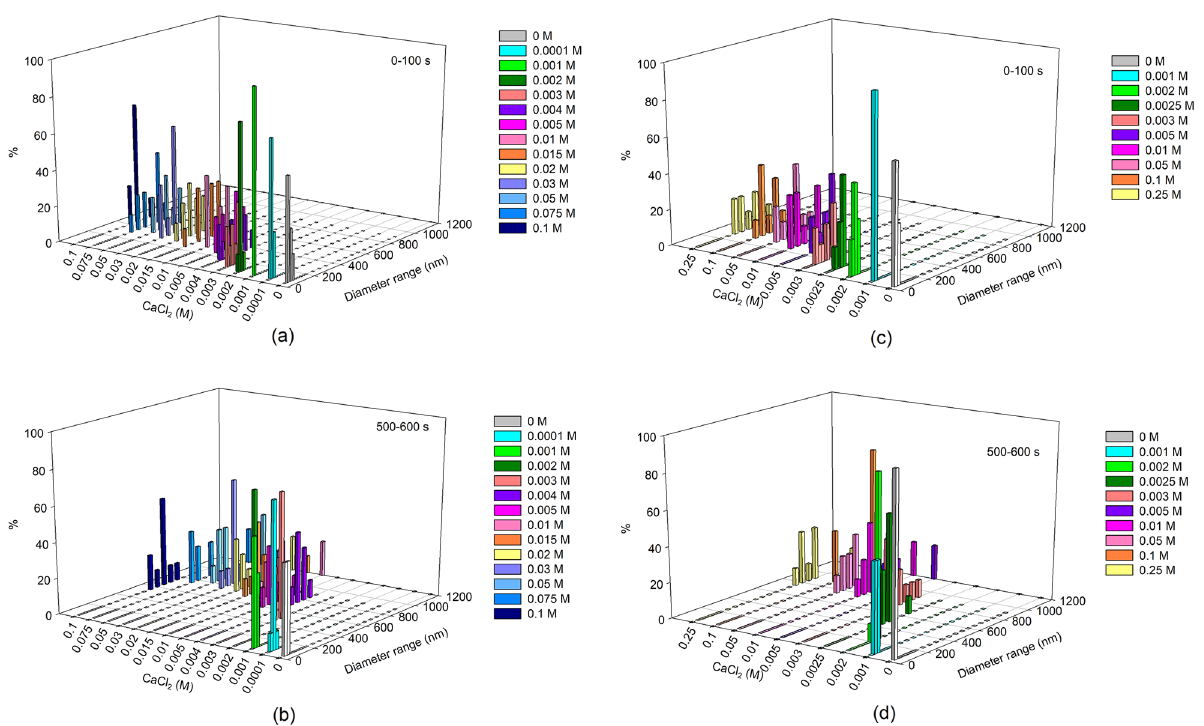
at last 100 s; c CaCl -SRNOM-QD systems within 0–100 s; and d 2 CaCl -SRNOM-QD systems at last 100 2 -QD systems 2